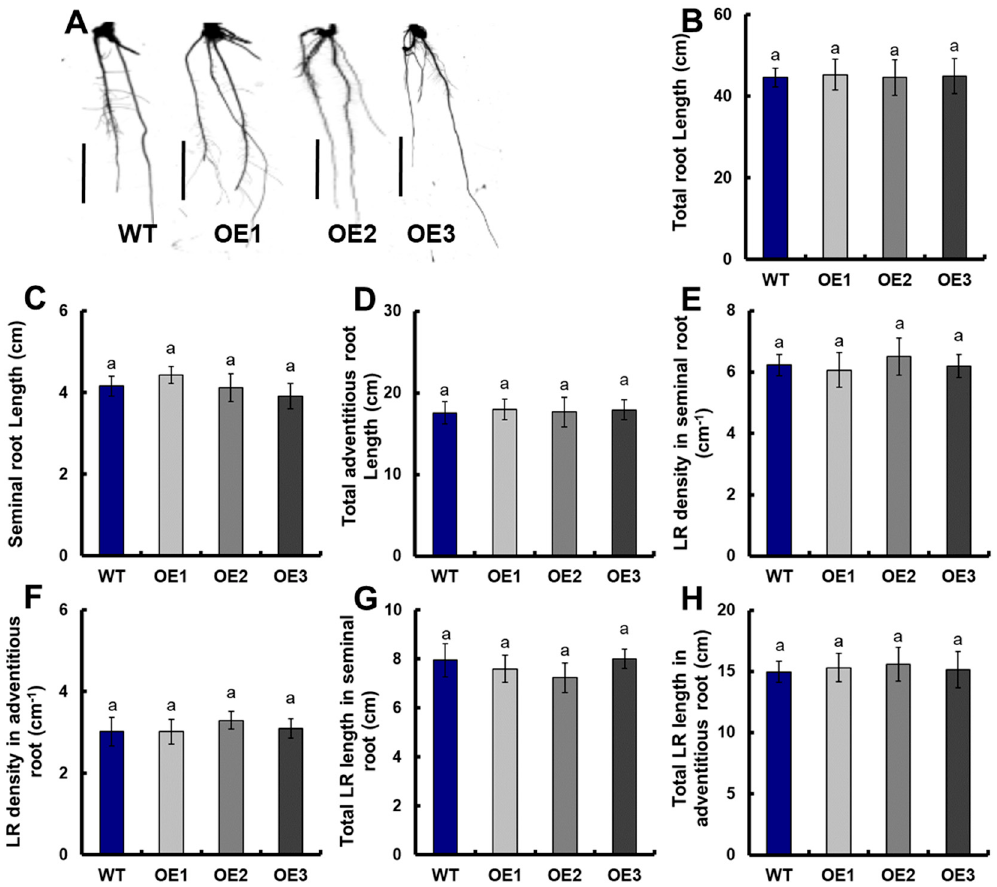
Figure 6. Root morphology of WT and OsNRT2.1 transgenic lines with NPA treatment under 0.5 mM of NO 3 − . Three-day-old normal grown WT and transgenic seedlings were transferred to nutrient solutions containing 1 µM of NPA from 100 mM of NPA that was dissolved in DMSO and the control containing the same amount of DMSO. Sampling was performed after seven days of treatment. ( A ) Root morphology (bar = 1 cm), ( B ) total root length, ( C ) seminal root length, ( D ) total adventitious root length, ( E ) LR density in seminal roots, ( F ) LR density in adventitious roots, ( G ) total LR length in seminal roots, and ( H ) total LR length in adventitious roots. Total root length is the sum of the seminal roots, adventitious roots, and all lateral roots. Error bars: SE ( n = 5). Significant differences between transgenic lines and WT are indicated by different letters ( p < 0.05, one-way ANOVA).